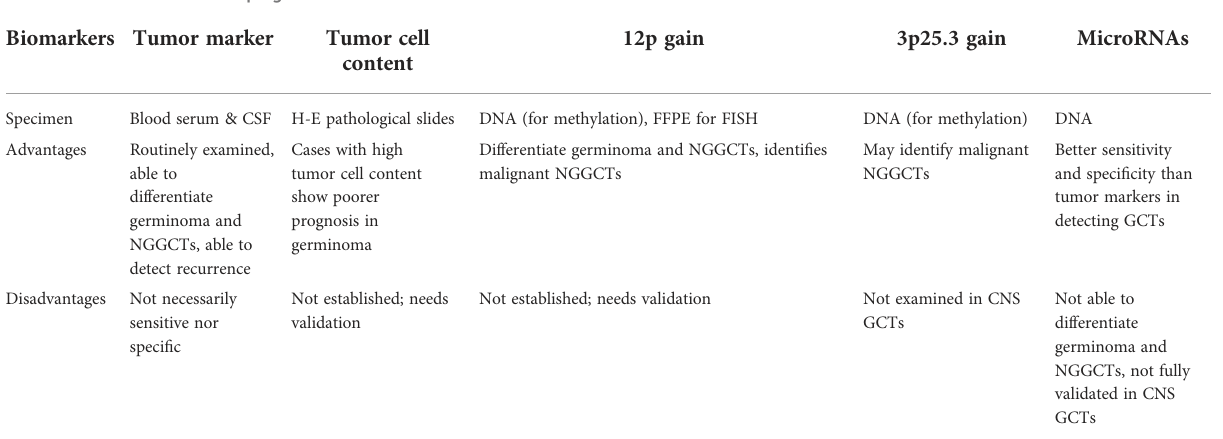
TABLE 4 Current and developing biomarkers for CNS